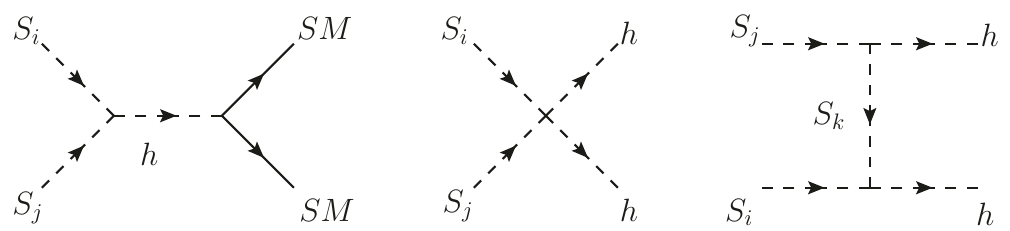
Figure 3 . Extended Higgs-portal scenario (ESHP): annihilation processes involving particles of the dark sector, S i , i = 1 , 2.